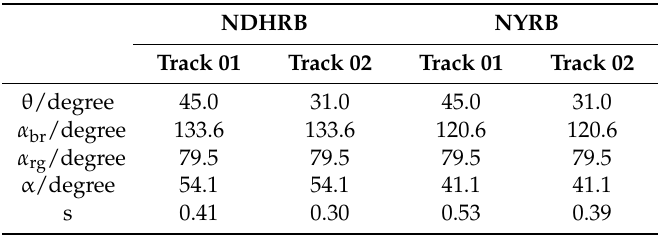
Figure 5. Relation of the sensitivity s as a function of the radar incidence angle θ and the horizontal angle α . Table 3. Sensitivity to the longitudinal displacements of the NDHRB and the NYRB, computed with the geometry of Track 01 and Track